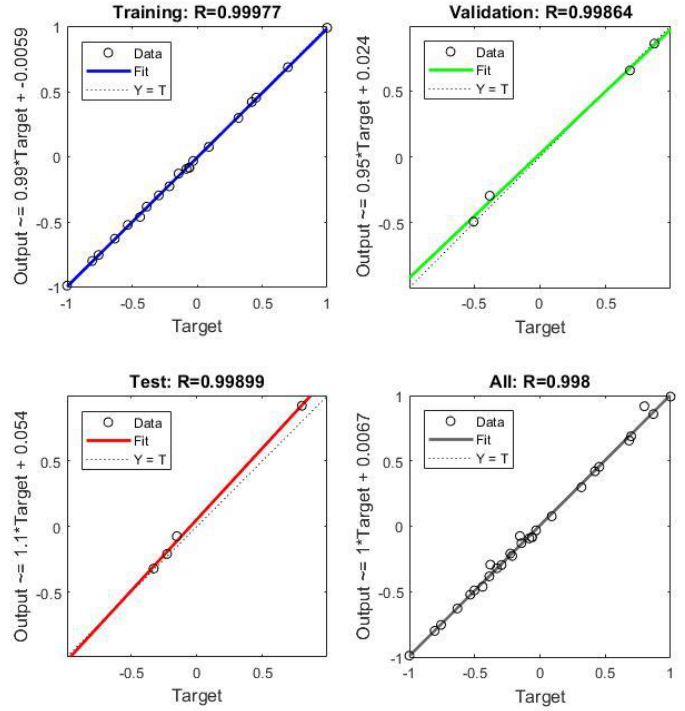
Figure 17. The regression analysis of the BP neural network.